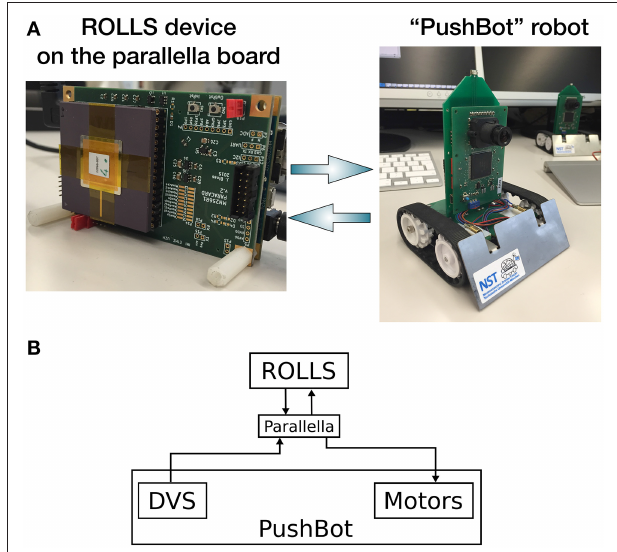
FIGURE 1 | (A) Information flow between the three main components: ROLLS, Parallella, and the Pushbot, in particular, its sensor DVS and two motors. (B) The hardware setup used in this work: the neuromorphic processor ROLLS is interfaced to a miniature computer Parallella, which communicates with the Pushbot robot over a dedicated WiFi